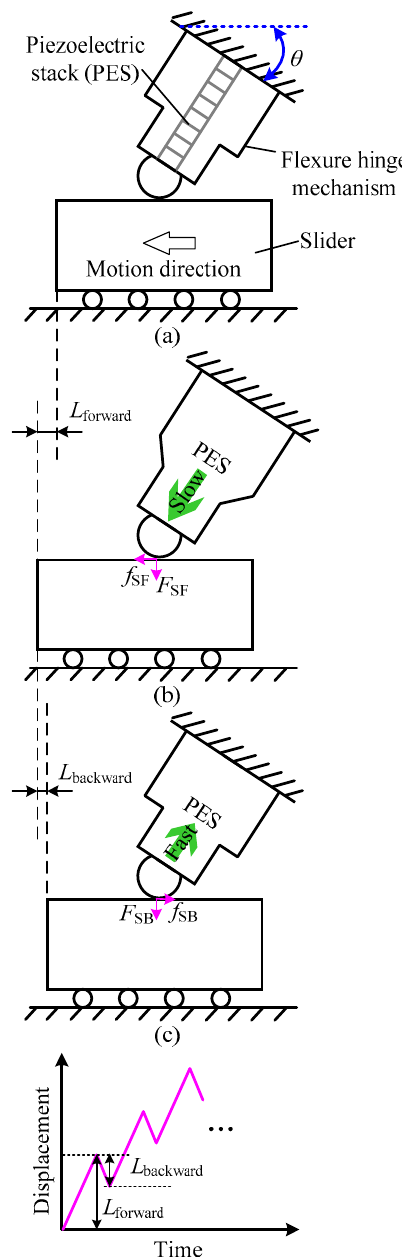
Figure 1. Schematic diagrams illustrating the normal stick-slip principle: ( a ) the initial contact between the flexure hinge mechanism and the slider, ( b ) the “stick” stage, ( c ) the “slip” stage, and ( d ) the stepping displacement.